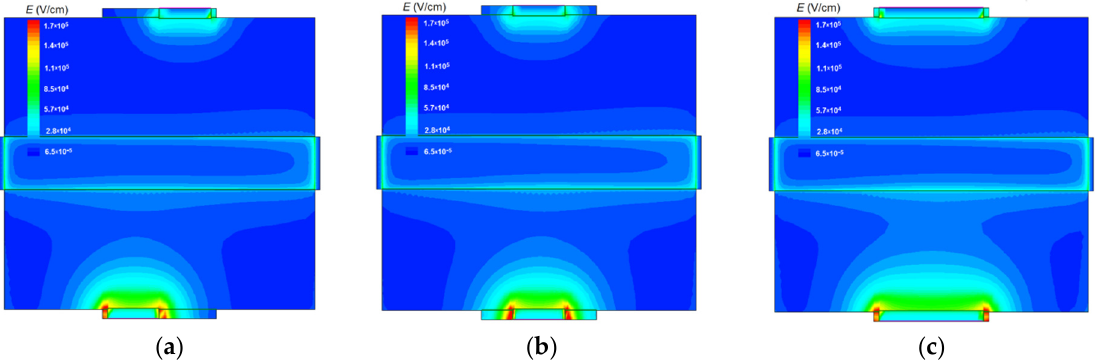
Figure 3. Electric field strength distributions of the A cross section at the distance Z = 30 nm from the BOX calculated at V bg = 0.5 V for ( a ) DEP-1, ( b ) DEP-2, and ( c ) DEP-3 sensors. H G = 100 nm.